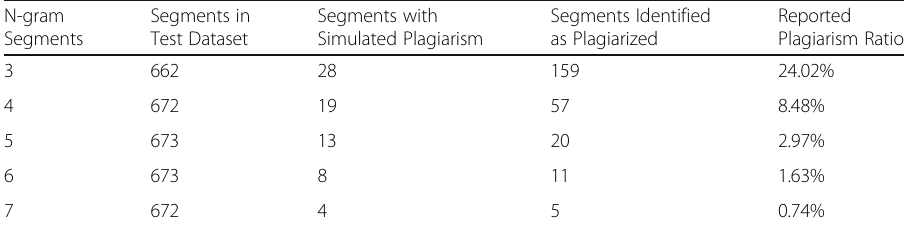
Table 18 Results of experiment III where the dataset is injected with plagiarism-simulated sentences and run against the entire corpus N-gram